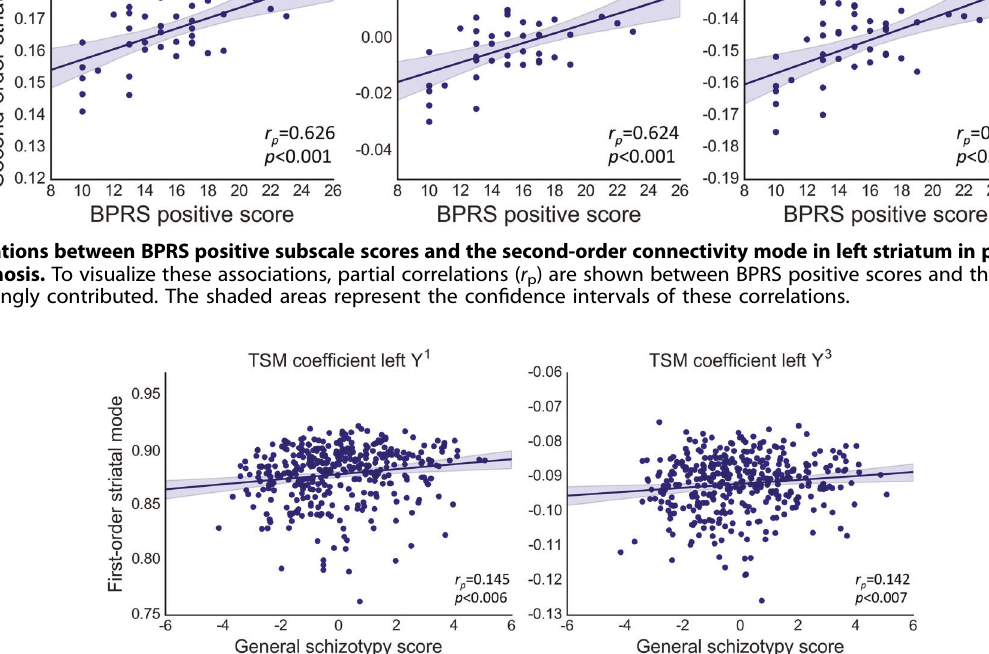
Fig. 4 Signi fi cant association between general schizotypy and the fi rst-order connectivity mode in left striatum. To visualize this association, partial correlations ( r p ) are shown between PLEs general factor score estimates and the linear and cubic TSM coef fi cients modeling the connectivity mode in the Y direction that most strongly contributed to the association. The shaded areas represent the con fi dence intervals of these